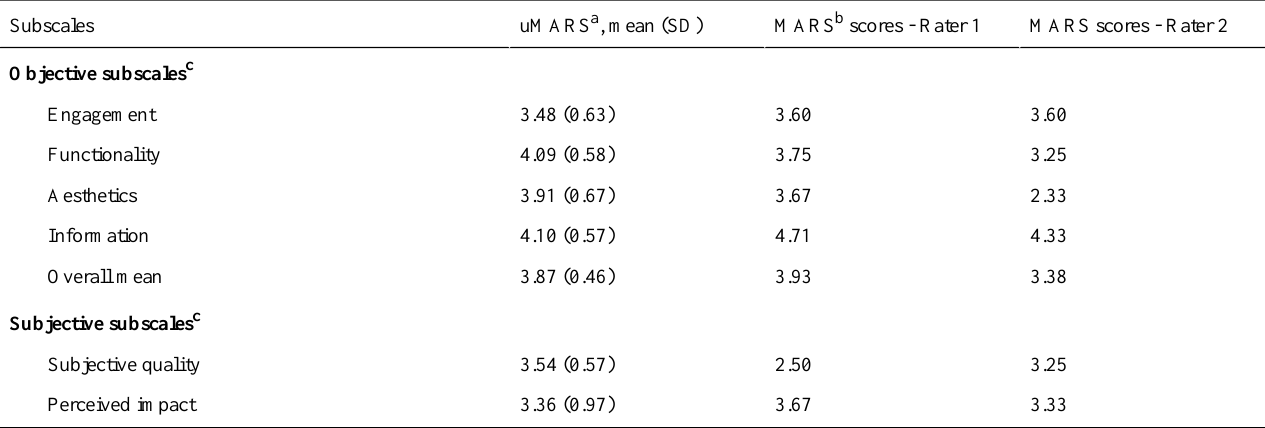
Table 1. Ratings of PTSD Coach Australia on the uMARS and